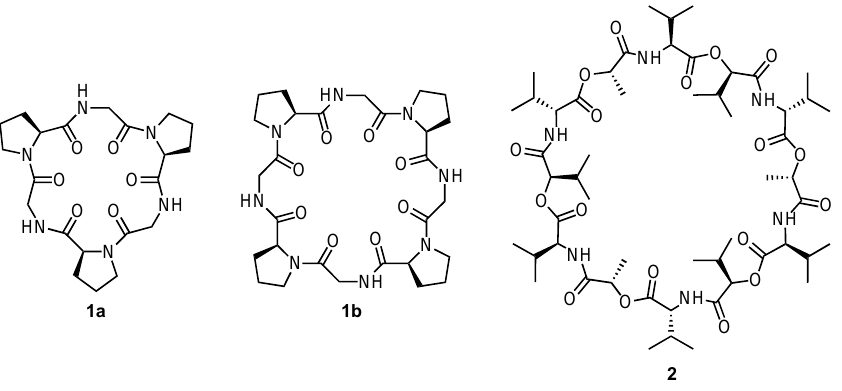
Scheme 1. Structures of cyclopeptides 1a , b and of valinomycin 2 .